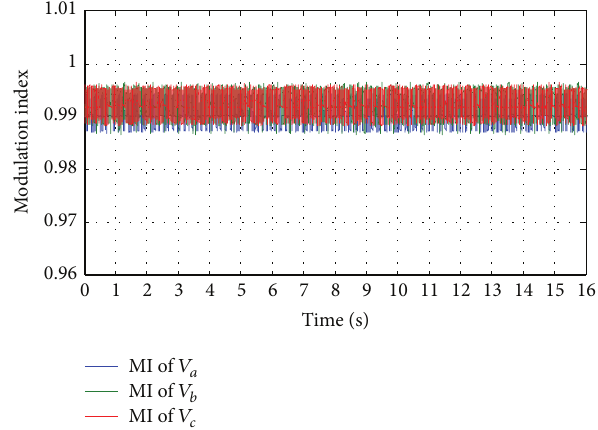
Figure 27: Modulation indexes for all three phases.